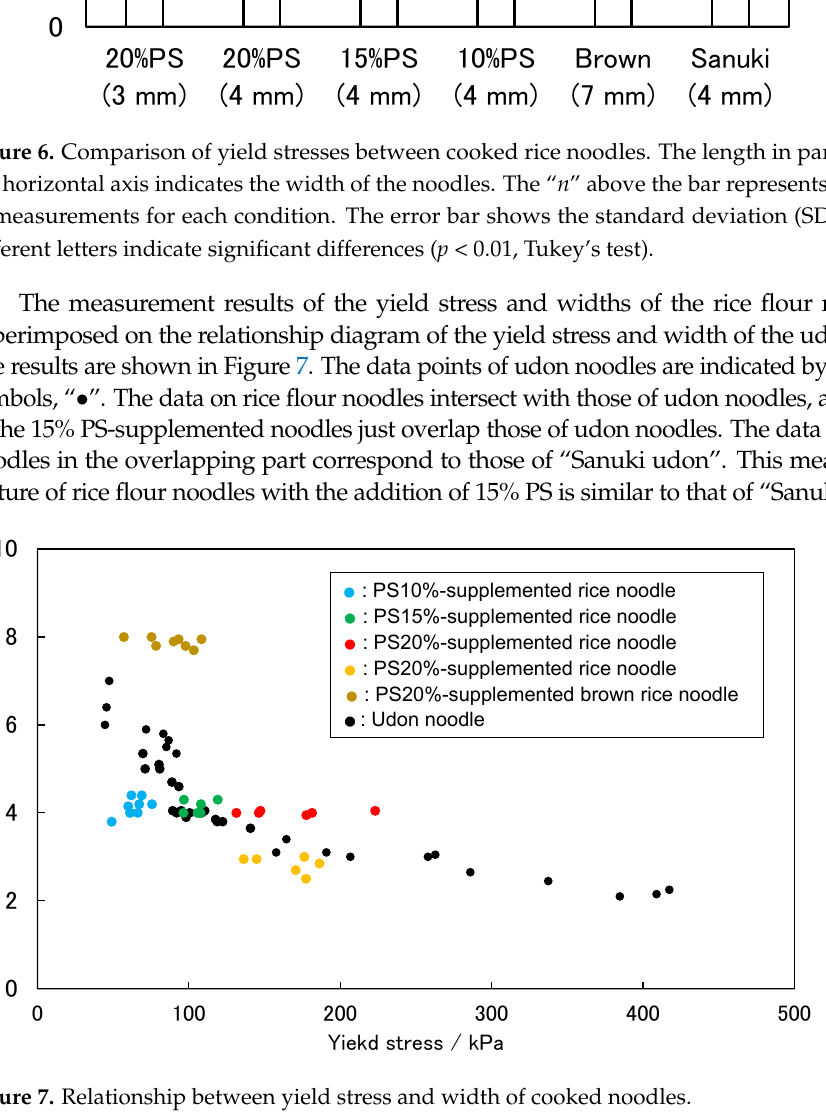
Figure 6. Comparison of yield stresses between cooked rice noodles. The length in parentheses on the horizontal axis indicates the width of the noodles. The “n” above the bar represents the number of measurements for each condition. The error bar shows the standard deviation (SD). Bars with different letters indicate significant differences ( p < 0.01, Tukey’s test).